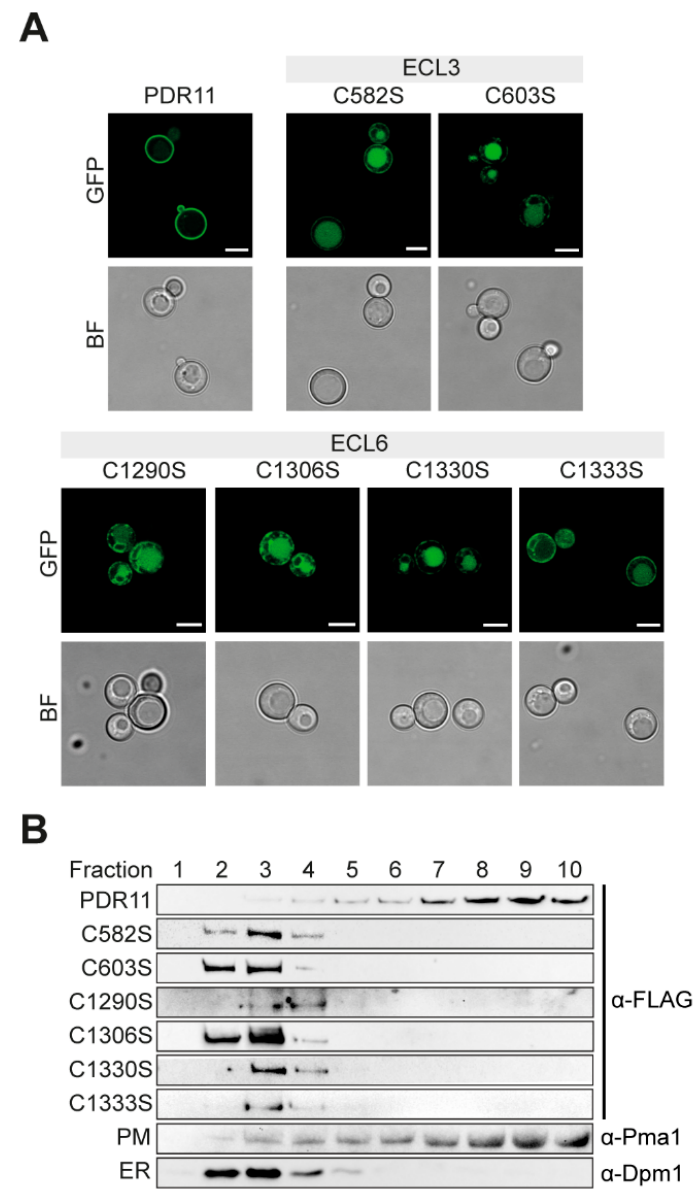
Figure 4. Pdr11p cysteine mutants display impaired trafficking to the plasma membrane. ( A ) hem1 ∆ aus1 ∆ pdr11 ∆ cells expressing genomically integrated wild-type and mutant Pdr11p-GFP were grown to the mid-logarithmic phase before imaging by fluorescence (GFP) or bright field (BF) microscopy. Scale bars, 5 µ m. ( B ) Sucrose gradient fractionation of membranes prepared from hem1 ∆ aus1 ∆ pdr11 ∆ cells expressing genomically integrated wild type and mutant Pdr11p-GFP. Gradient fractions were assayed by immunoblotting using antibodies against the FLAG epitope engineered into Pdr11p or two organellar markers (Pma1p and Dpm1p). Shown are fractionation profiles for marker proteins corresponding to membranes of cells expressing wild-type Pdr11p-GFP, but profiles were determined individually for each membrane preparation, with similar results. PM, plasma membrane; ER, endoplasmic reticulum. Results are representative of at least two independent experiments.